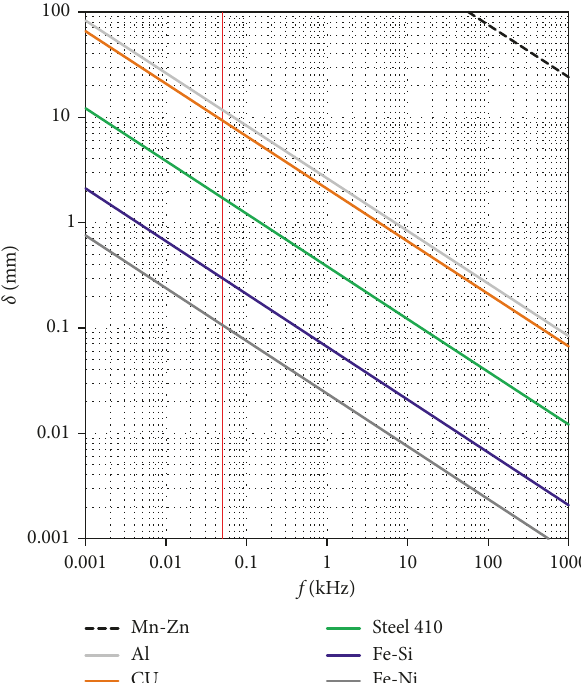
Figure 2: Skin depth vs. frequency for some materials at room temperature; red vertical line denotes 50Hz frequency